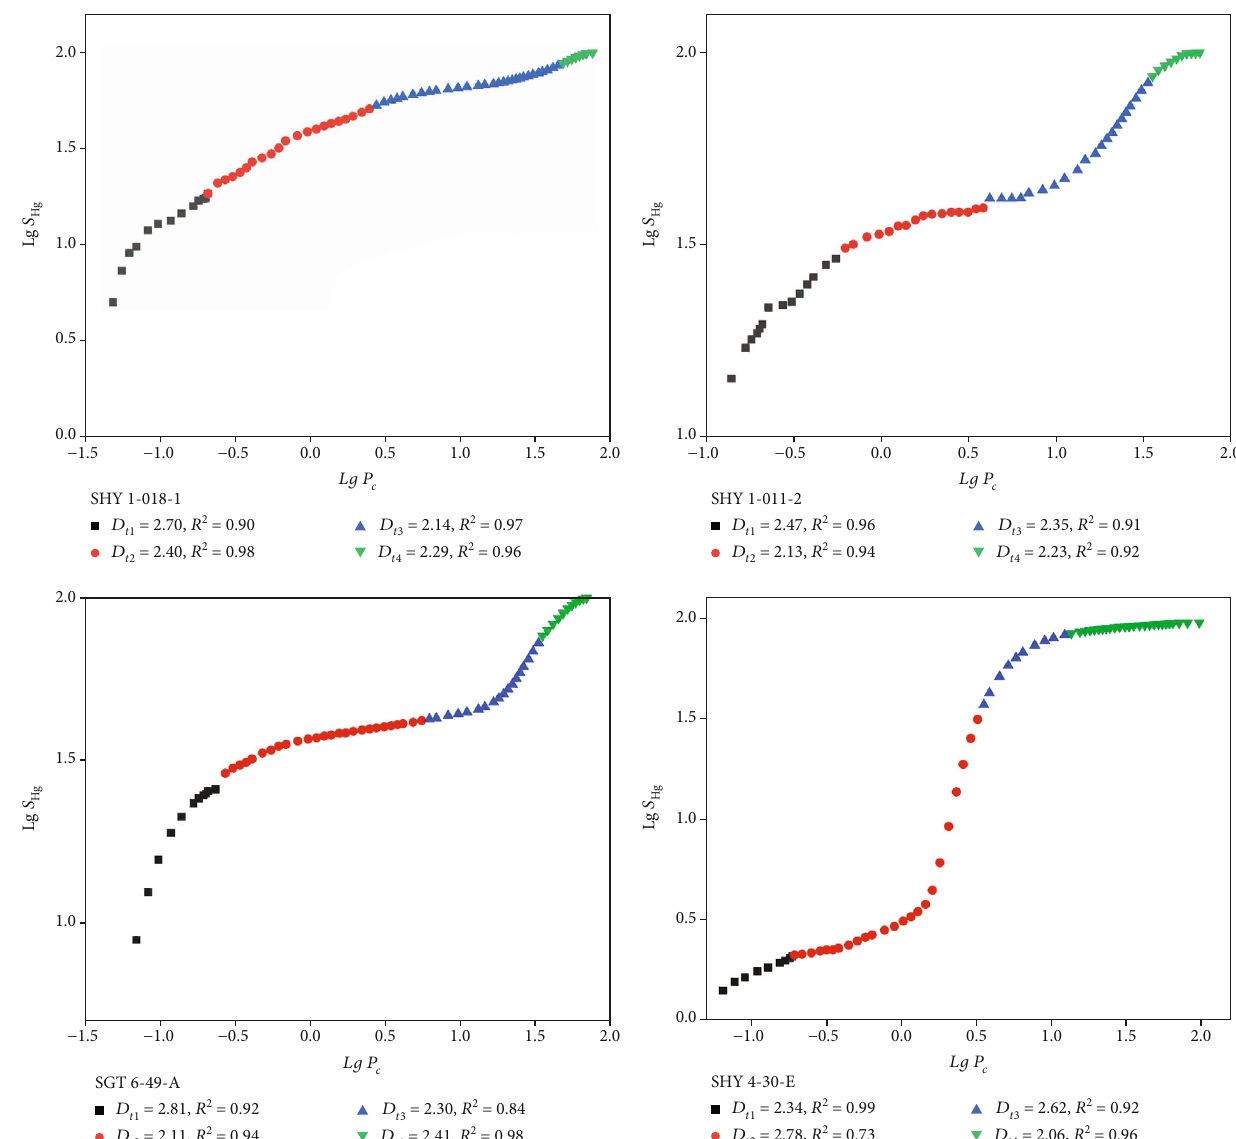
Figure 10: Fractal dimension calculation with a tubular pore model ( D = 2 + slope ) using four-straight-line fi